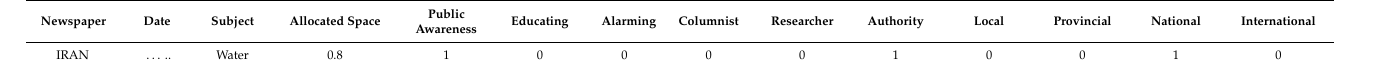
Table 3. A cross-section of the database prepared for this